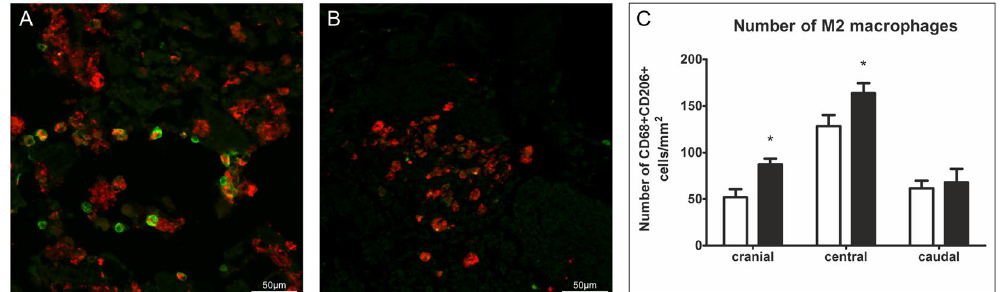
Figure 8. Analysis of microglia/macrophage polarization at a lesion site. ( A , B ) The representative images of CD206 (green) and CD68 (red) staining in the central part of the lesion. ( A ) – laser group, ( B ) – control group.( C ) We considered the double labeled cells to be M2 microglia/macrophages and we found statistically significant differences in their numbers between the group in cranial ( − 2 mm) and central (epicenter) parts of the spinal cord. There was no difference in the caudal ( + 2 mm) part. n = 4 per group. The values are expressed as mean ± SEM. * p < 0.05.